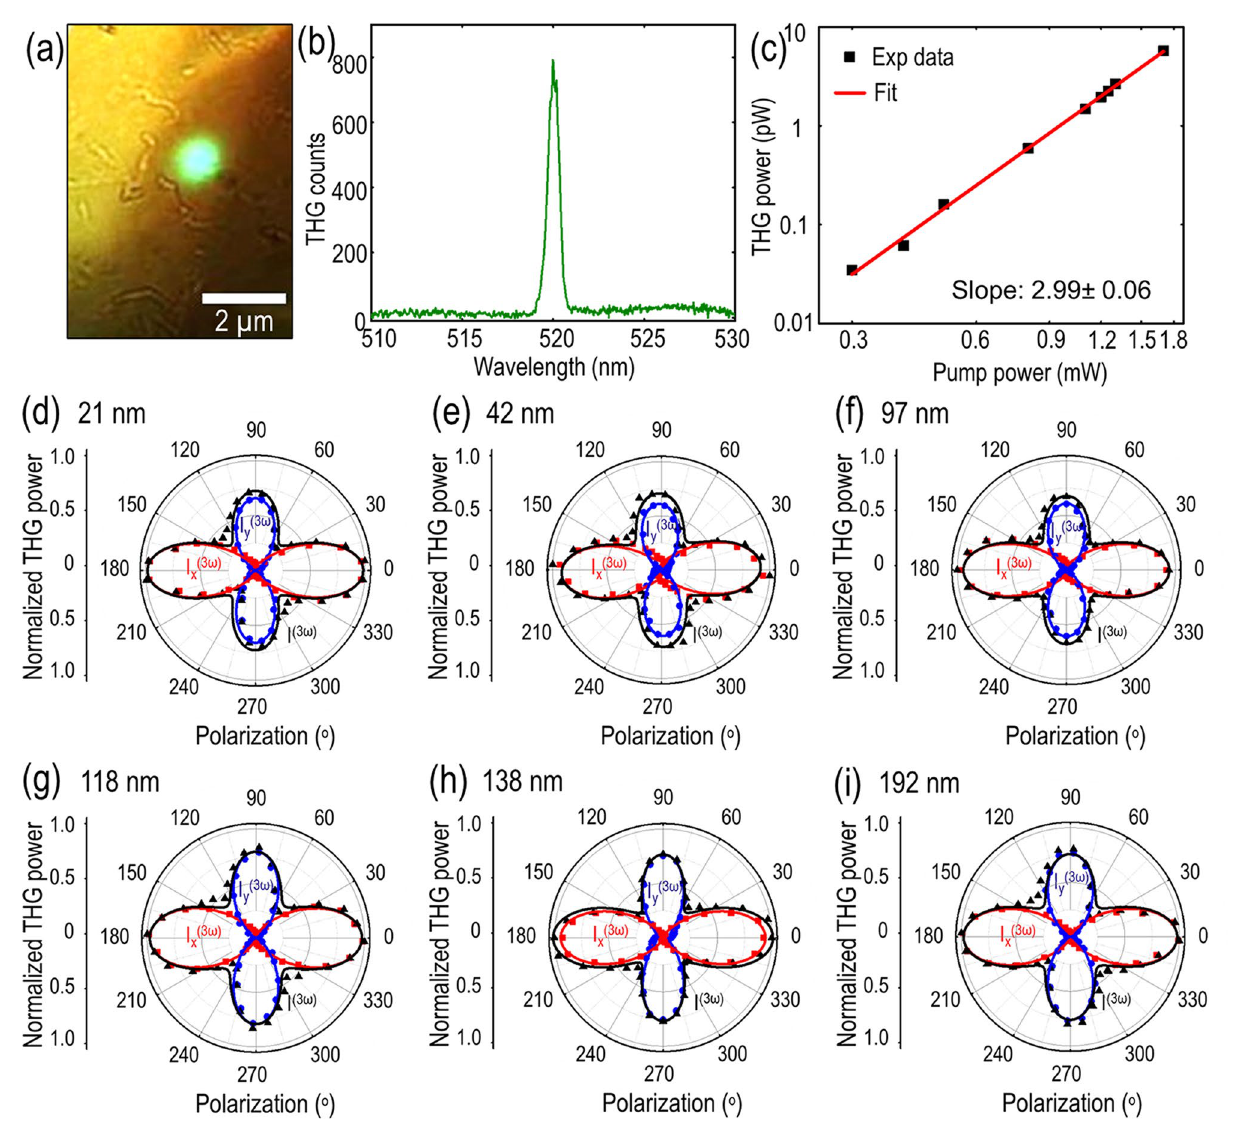
Figure 3. ( a ) Transmission microscope image with THG emission from the 21 nm-thick franckeite flake. ( b ) Measured THG emission spectrum showing the peak emission wavelength at 520 nm which is exactly one-third of the excitation wavelength at 1560 nm. ( c ) Log-scale plot of the THG emission power as a function of the pump power. ( d – i ) Angular dependence of the THG emission power on the incident linear polarization angle for six franckeite flakes with the thicknesses of 21, 42, 97, 118, 138 and 192 nm. Black triangles, red squares and blue circles correspond to the measured total, x -component and y -component of the THG emission power, 3 ω) ( 3 ω) I ( 3 ω) , I ( x and I y , respectively. The corresponding theoretical fittings are plotted as solid